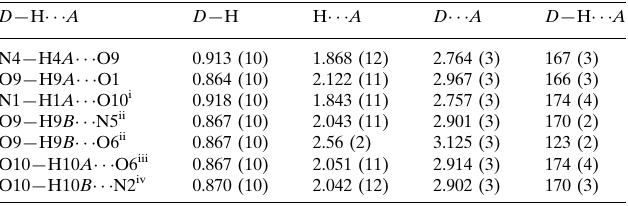
Hydrogen-bond geometry (A˚ , (cid:2)